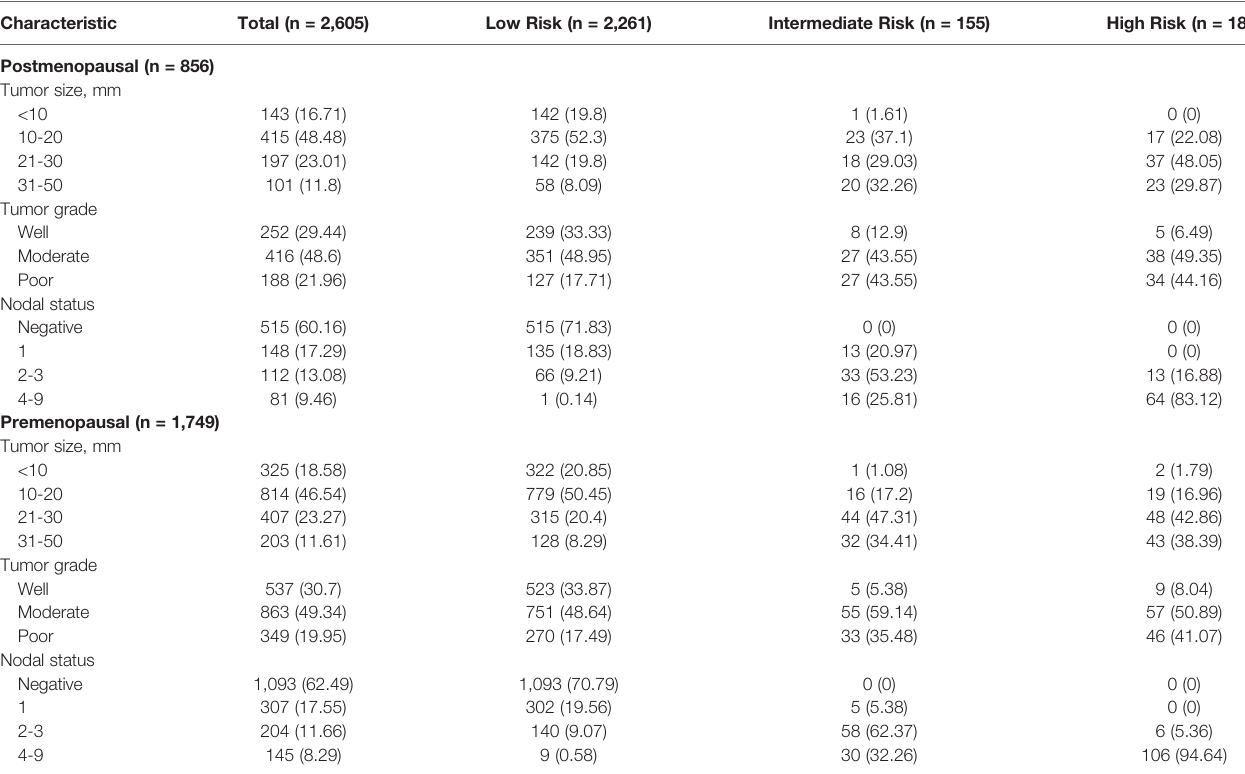
TABLE 2 | Distribution of risk categories according to menopausal status. Characteristic